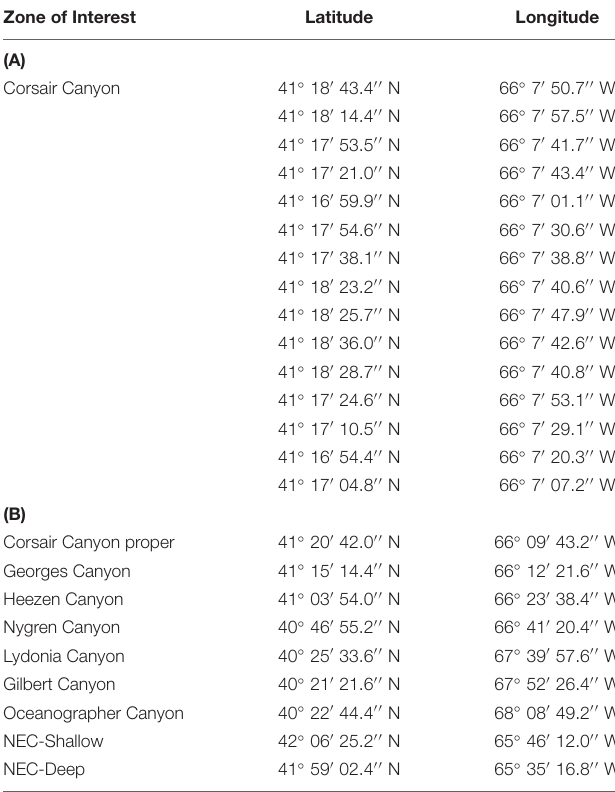
TABLE 2 | Geographic coordinates of (A) endpoints of hydrodynamic tracks in the vicinity of Corsair Canyon and (B) approximate center points of each zone of